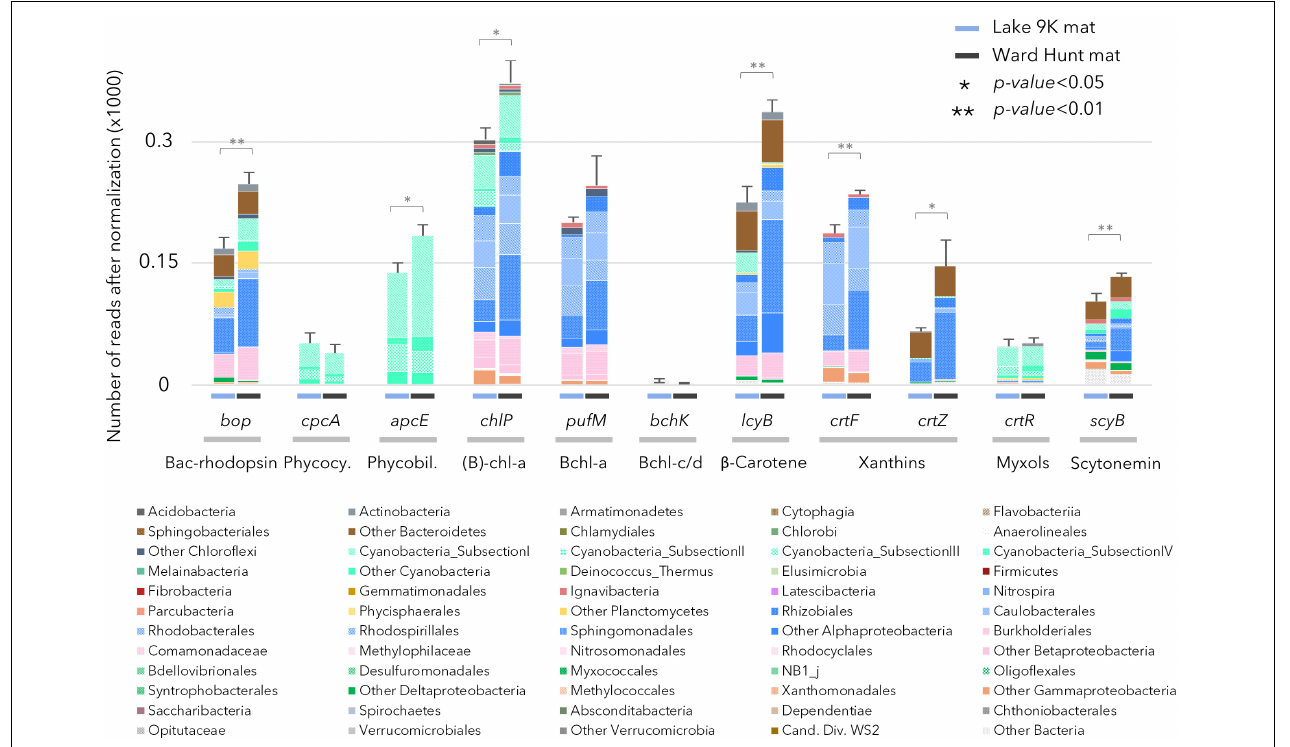
FIGURE 3 | Relative abundance of genes after normalization involved in pigment production in the mat metagenomes for Lake 9K (left bar in each pair) and Ward Hunt Lake (right bar in each pair). The number of asterisks indicates the significance of Mann–Whitney U -tests between mean values from Lake 9K and Ward Hunt Lake metagenomes ( n = 6). Color code of the bars is the same as in Figure 1 : Bacteroidetes (browns), Cyanobacteria (light greens), Planctomycetes (yellow), Alphaproteobacteria (blue), Betaproteobacteria (pink), Deltaproteobacteria (dark green), Gammaproteobacteria (orange), and Verrucomicrobia (gray). Bacteriorhodopsin-like protein (Bac-rhodopsin, PFAM family PF01036), Phycocyanin (Phycocy.), Phycobiliprotein (Phycobil.), Chlorophyll- a + Bacteriochlorophyll- a [(B)-chl- a ], Bacteriochlorophyll- a (Bchl- a ), Bacteriochlorophyll- c / d (Bchl- c / d